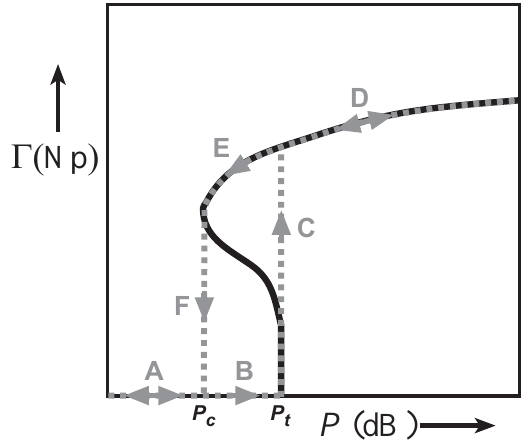
Fig. 1. A theoretical curve showing the relationship between anomalous absorption and heater power (solid curve). The dashed lines show the different paths that lead to the hysteresis